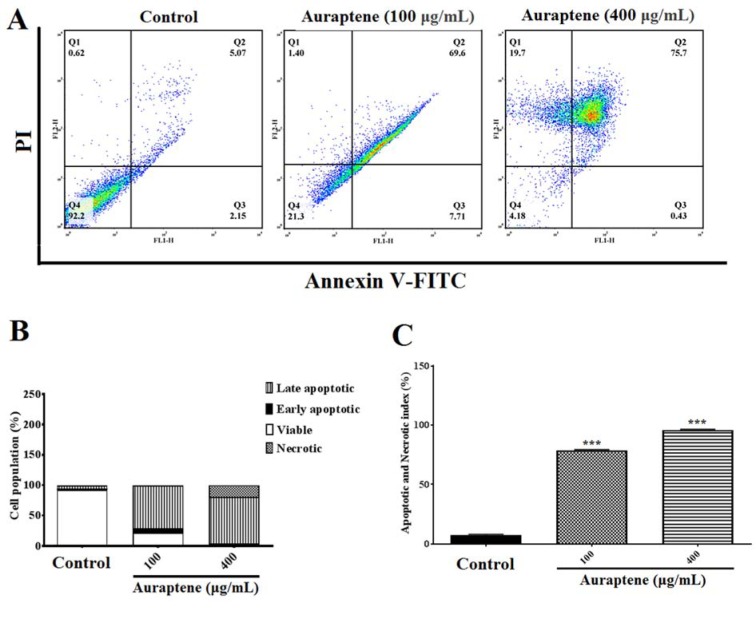
(A) The measurement of apoptotic and necrotic cells was performed by the annexin V-FITC/PI staining assay 24 hours after treatment by auraptene (100 and 400 μg/mL). Auraptene induced apoptosis concentration-dependently 24 hours after treatment compared to the control group. FL2-H and FL1-H are PI and annexin V-FITC, respectively. The annexin V-FITC conjugated protein was bound to the phosphatidyl serine-expressing cell surface, which is an early apoptosis marker. The cells were stained with PI, a non-penetrating color to the DNA, indicating necrotic cells. The cells stained with PI and annexin V-FITC represent the endpoints of apoptosis and the initial phase of necrosis. The percentages of viable, early/late apoptotic, and necrotic cells in the treated samples compared to the control group, 24 hours after treatment by auraptene (Q1: annexin V−/PI +, necrotic cells; Q2: annexin V+ /PI +, late apoptotic cells; Q3: annexin V+ /PI −, early apoptotic cells; Q4: viable cells). Tests were repeated in triplicate. (B) and (C) show the percentage of apoptosis process in each phase and the apoptotic and necrotic index in the treated samples as compared with the control group, 24 hours after treatment, respectively. Each column represents the mean ± standard error in the samples. ***P<0.001 as compared with the control group (n=5)